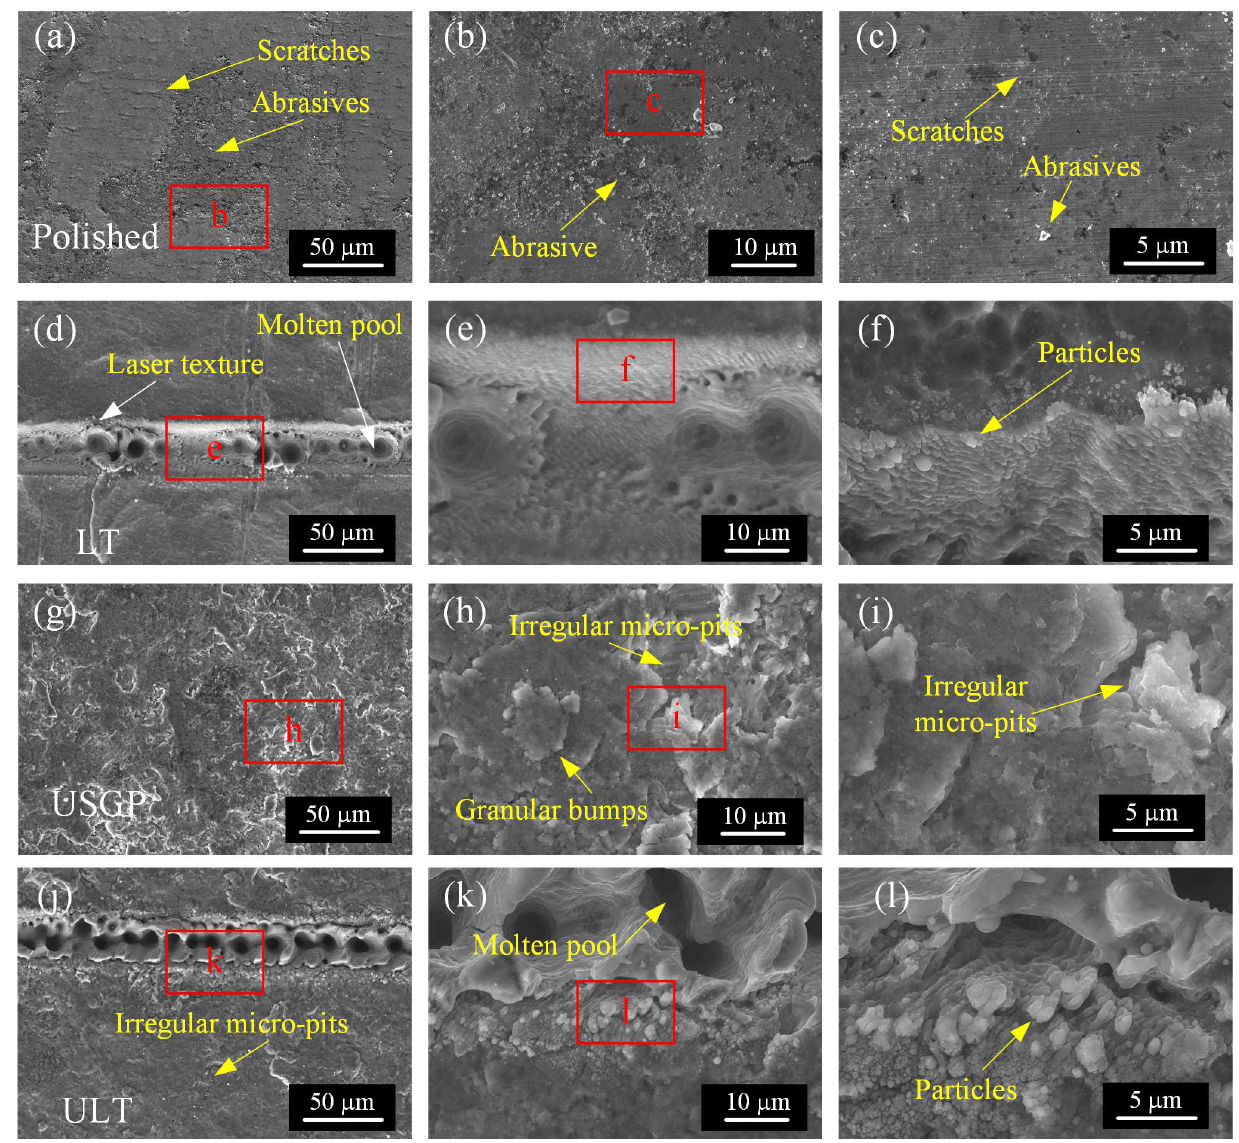
Figure 7. SEM images of the details of polished ( a - c ), LT ( d - f ), USGP ( g - i ), and ULT ( j - l ) samples before sliding wear. The figures ( b , e , h , k ) are the enlarged images of the areas with red letters in figure ( a , d , g , j ), and figure ( c , f , i , l ) are the enlarged appearances of the areas with red letters in figure ( b , e , h , k ),